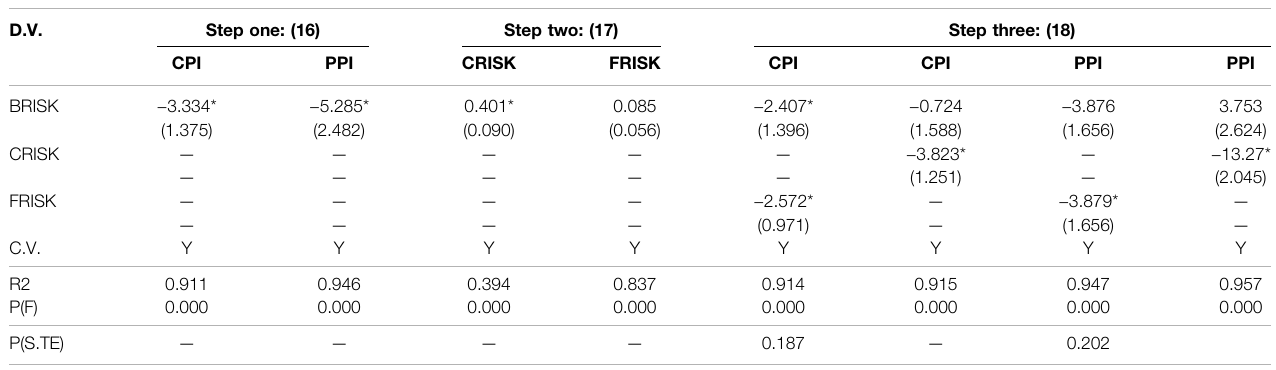
TABLE 7 | Test results of the spillover mechanism of international crude oil market upward returns risk under full